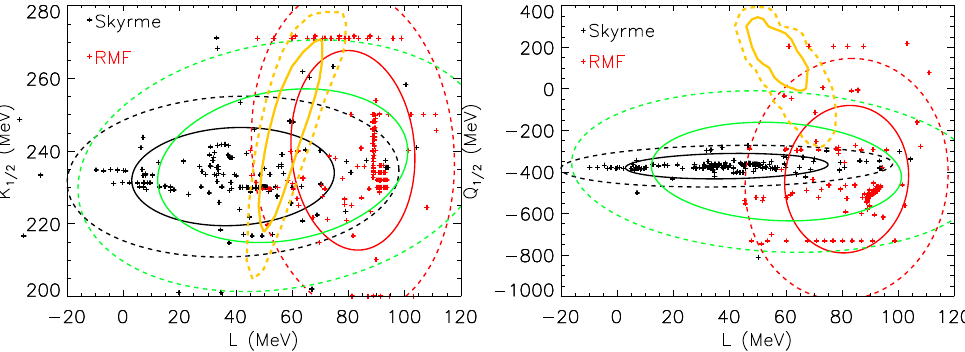
Figure 4. The same as Figure 3 except the left and right panels show the L − K 1/2 and L − Q 1/2 correlations,